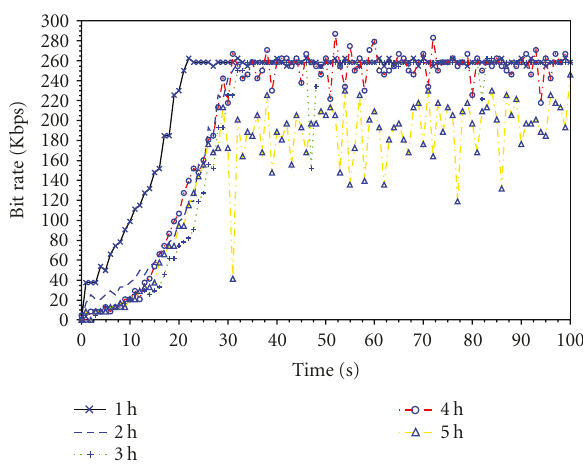
Figure 8: “Less demanding real time” rate variation.